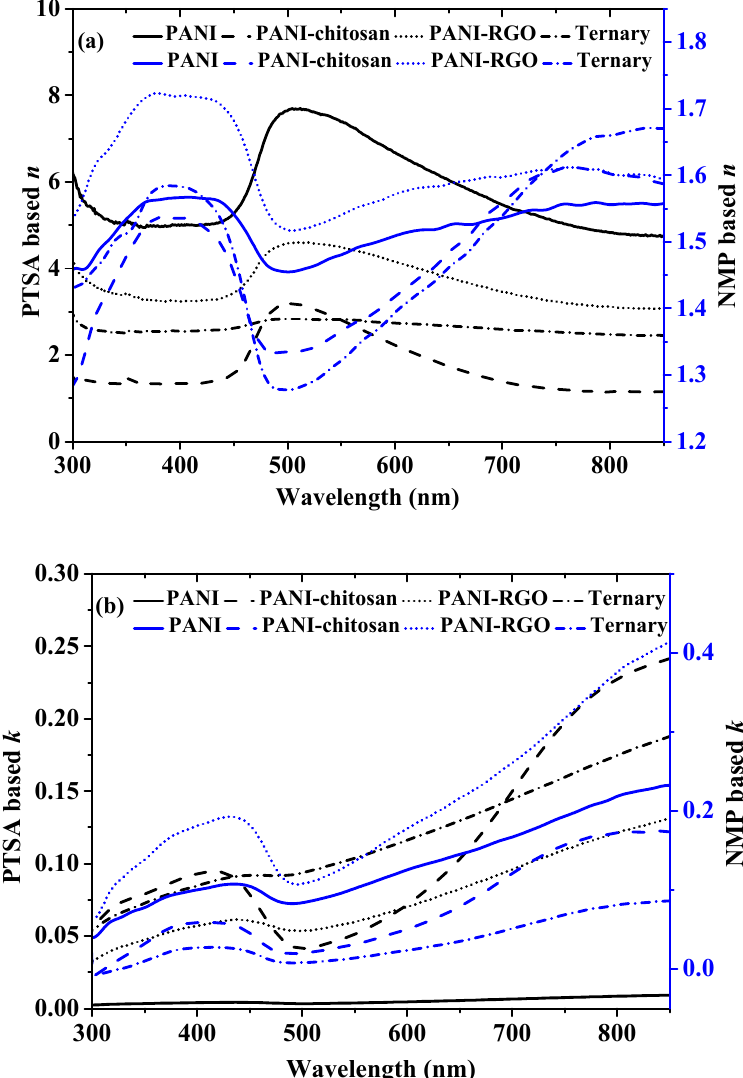
Figure 3. ( a ) Real part refractive index of PANI, PANI-chitosan, PANI-RGO and Ternary composites dispersed in both PTSA and NMP and ( b ) Imaginary part refractive index of PANI, PANI-chitosan, PANI-RGO and Ternary composites dispersed in both PTSA and NMP.